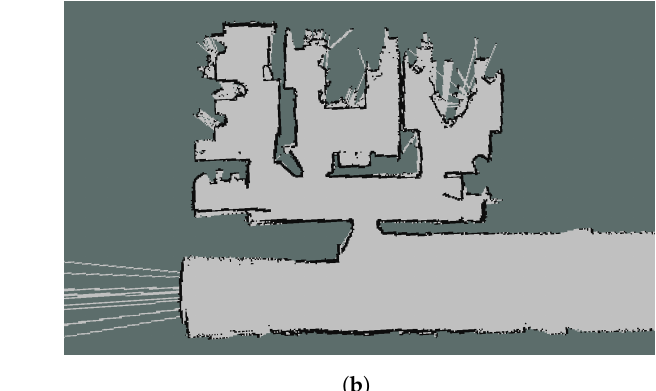
Figure 6. Map comparison between a pure 2D method and a traversable map where the height of the robot restricts the movement in certain areas such as under the tables. The results were obtained from a pre-recorded dataset [63] and default parameter values. The sensor is located at 60 cm of height, the resolution is of 0.4 ◦ with an horizontal FoV of 360 ◦ , the sensor frequency is 10 Hz and the robot height is 1 m: ( a ) resulting map given by Gmapping with a 2D LiDAR; ( b ) traversable (2.5D) map given by Gmapping using a 3D LiDAR and the Point-Cloud Fast Filter